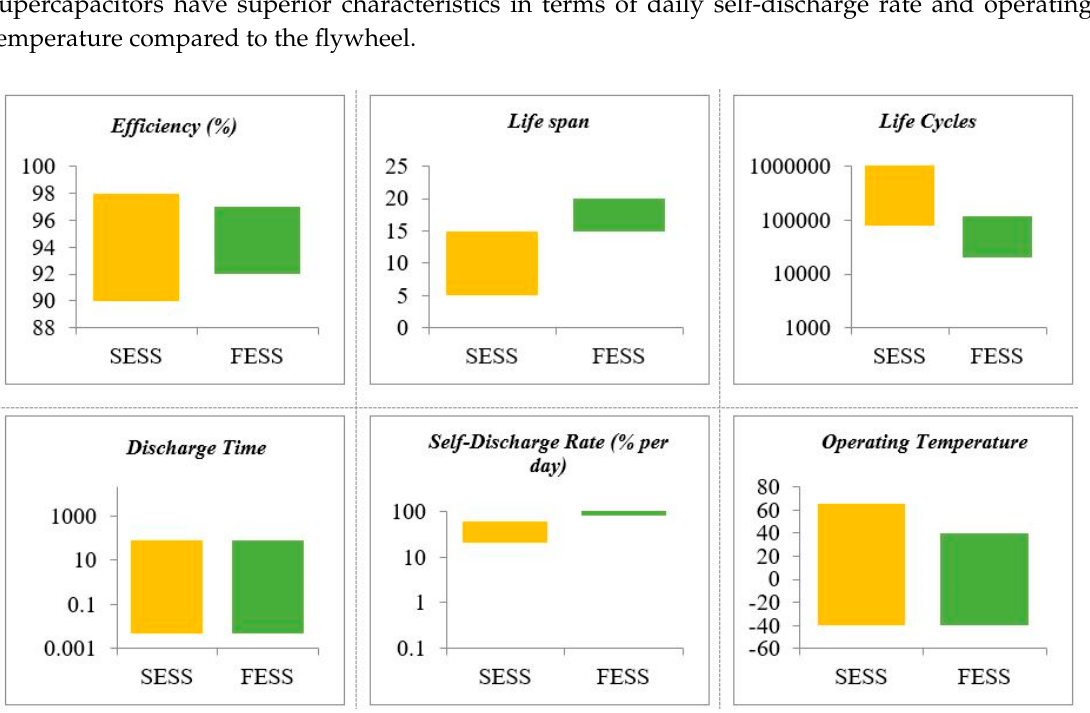
Figure 3. Energy storage systems (ESSs) characteristics.